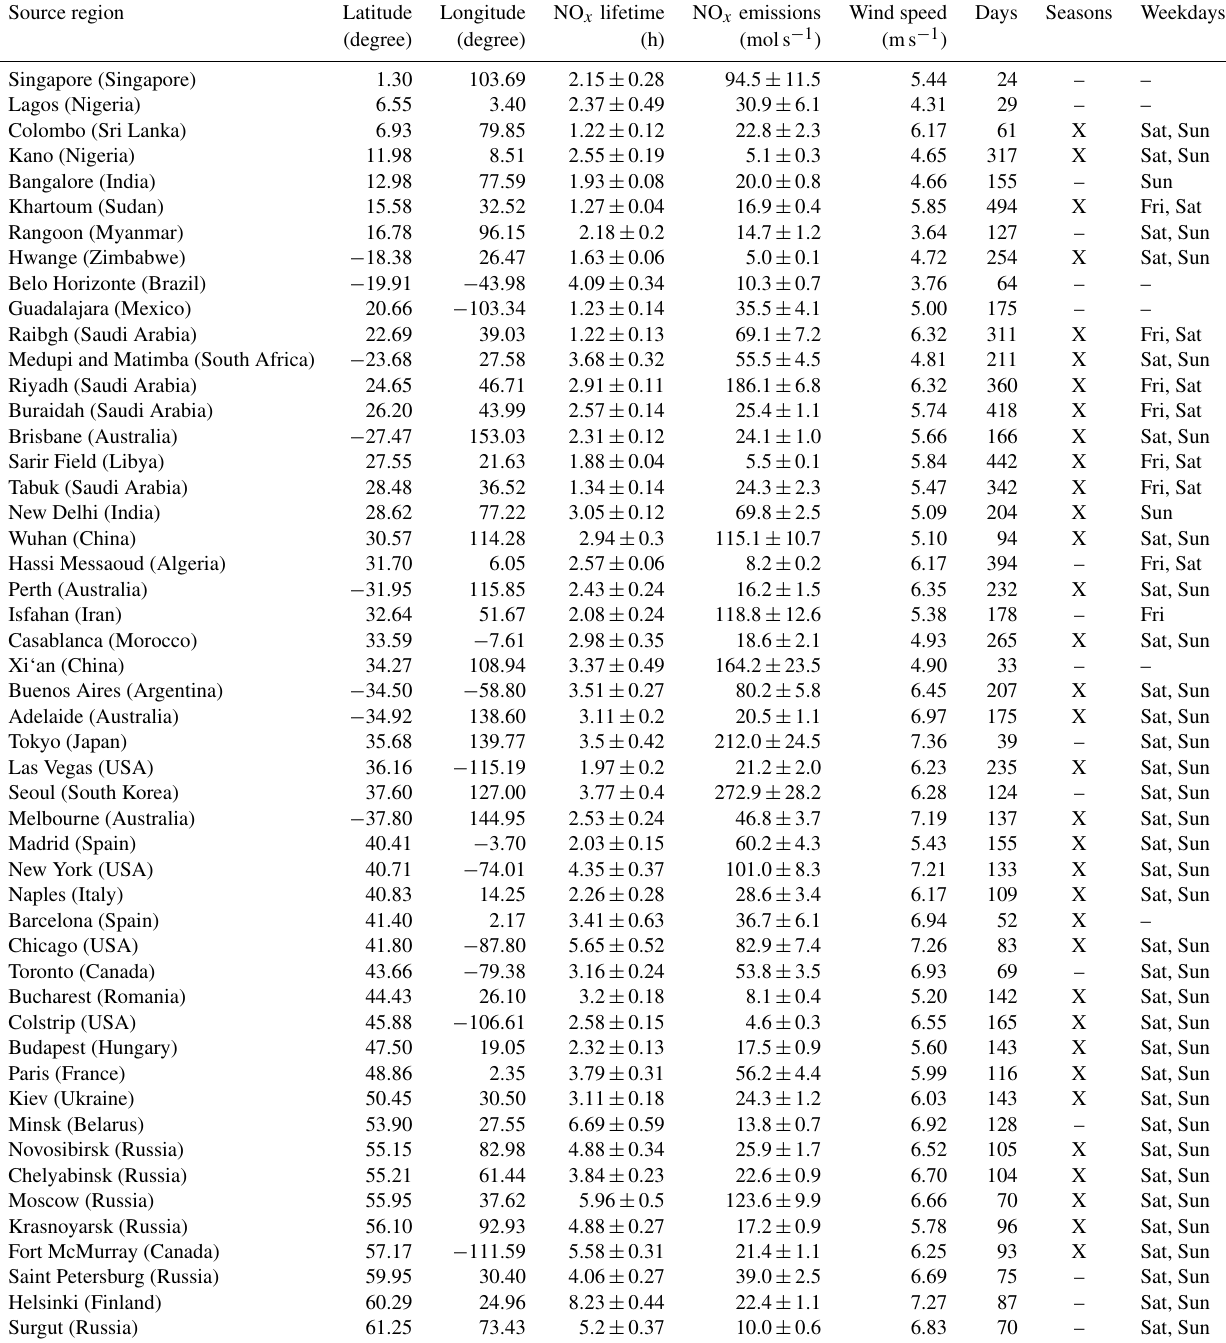
Table A1. NO x source regions sorted with increasing latitude with mean NO x lifetime and emissions, wind speed, available days, season flag and weekly cycle flag (X: possible, –: not possible). Errors are the standard deviation derived by the EMG fitting